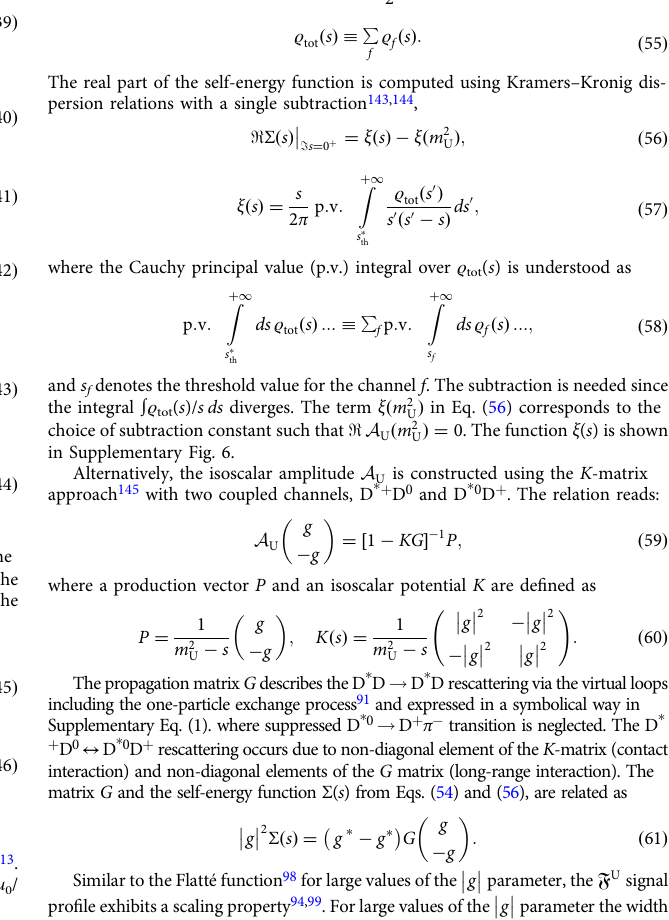
Similar to the Flatté function 98 for large values of the g pro fi le exhibits a scaling property 94,99 . For large values of the g